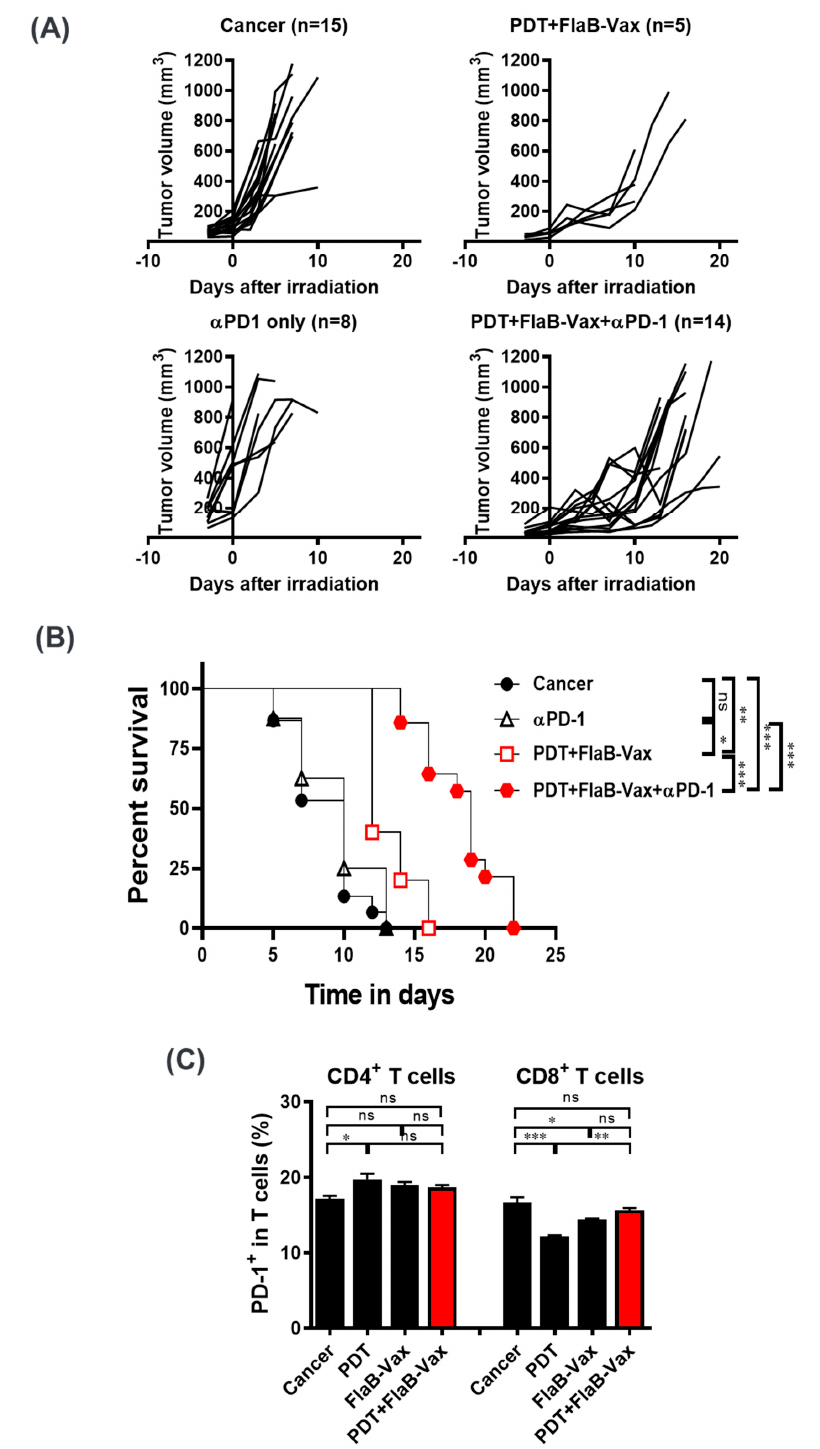
Figure 5. PD-1 blockade enhances the therapeutic efficacy of PDT + FlaB-Vax combination therapy. PDT and FlaB-Vax were combined with α PD-1 or isotype control antibodies (200 μ g/injection) that were administered 4, 7, and 10 days following PDT. A group of mice receiving the α PD-1 mAb without the combination treatment was also included. Tumor growth control ( A ) and survival ( B ) after treatments. PD-1-expressing cells in the spleen were determined ( n = 5 per group) ( C ). Statistical significance was calculated by one-way ANOVA for tumor growth and by Kaplan–Meier analysis for survival. *, p < 0.05; **, p < 0.01; and ***, p <